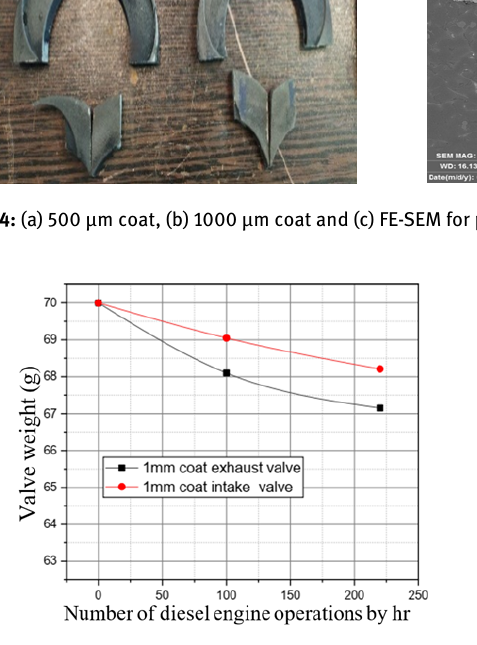
Figure 25: Relationship between valve weight change and diesel engine number of operations